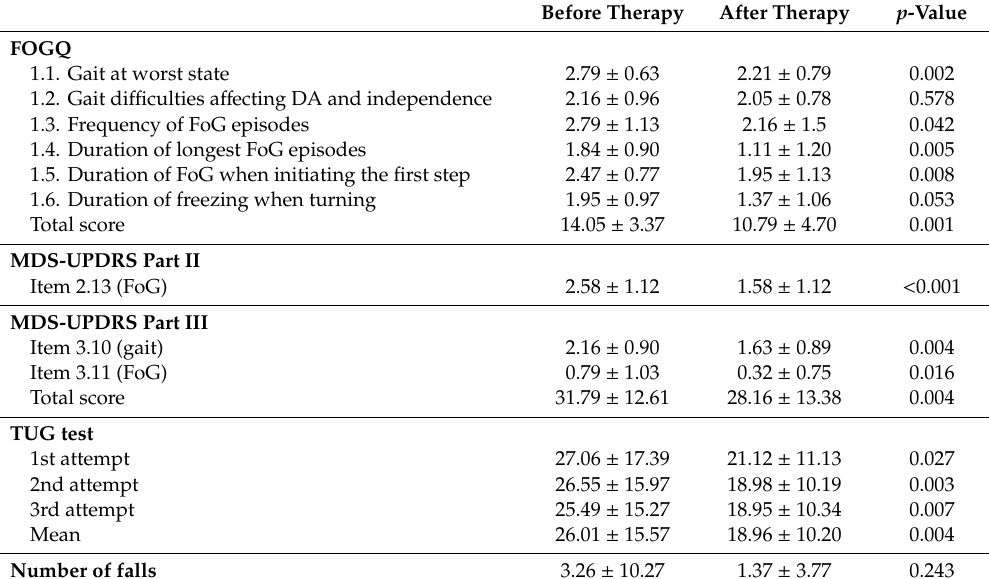
Table 2. Baseline and post-therapy features of patients included in the